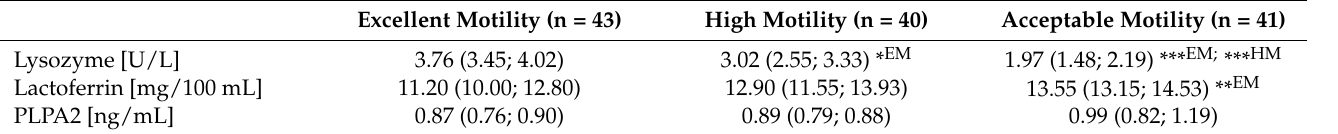
Table 4. Concentrations of selected antibacterial proteins in semen collected from the studied groups.